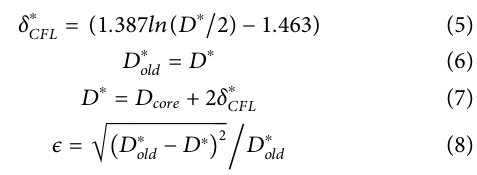
Frontiers in Physiology |